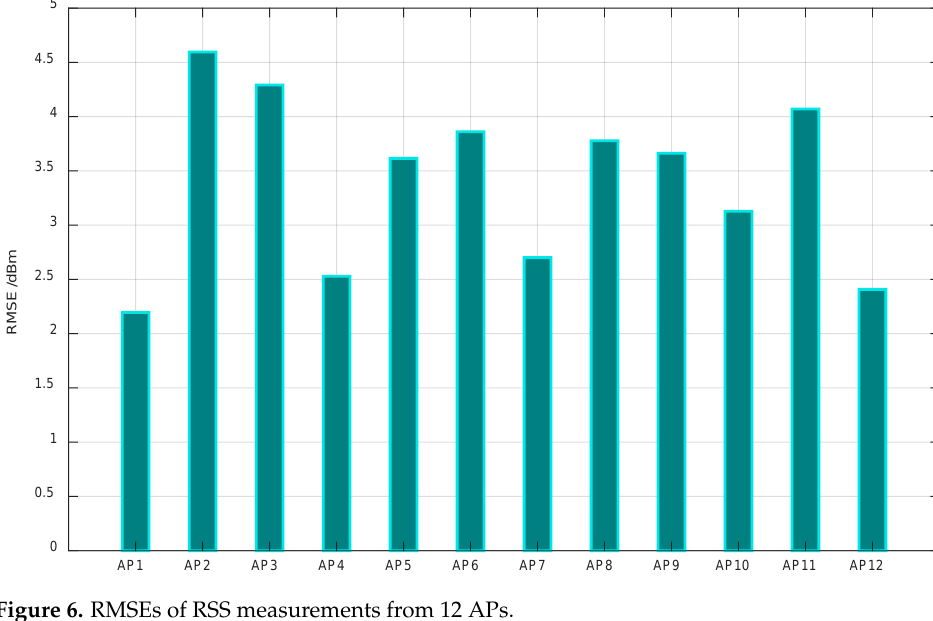
Figure 6. RMSEs of RSS measurements from 12 APs.